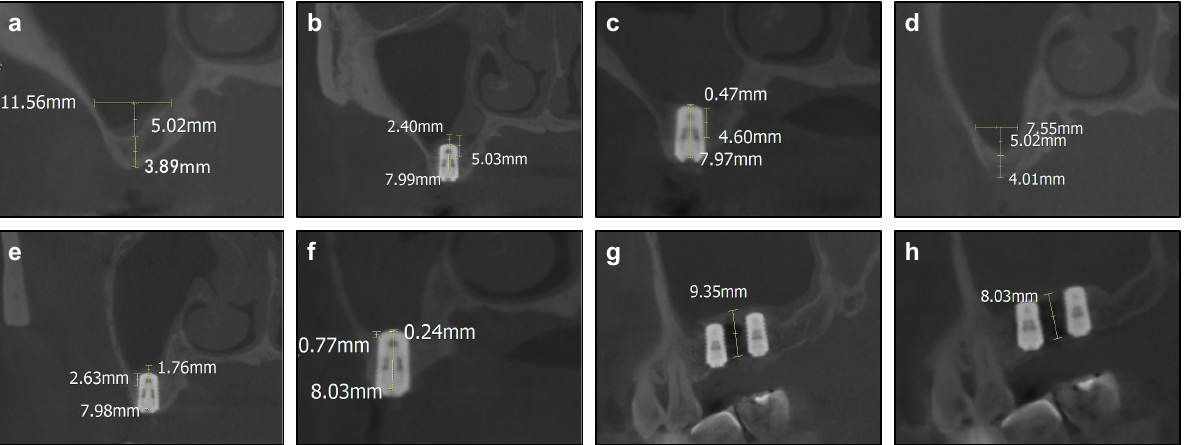
Figure 5. Cone-Beam Computed Tomography (CBCT) and measured data. ( a ) Residual bone height (RBH) of right maxillary first molar before elevation. ( b ) Height of the graft apically (aGH) of right maxillary first molar after elevation. ( c ) aGH of right maxillary first molar 6 months after elevation. ( d ) RBH of right maxillary second molar before elevation. ( e ) aGH of right maxillary second molar after elevation. ( f ) aGH of right maxillary second molar 6 months after elevation. ( g ) aGH between 2 implants after elevation. ( h ) aGH between 2 implants 6 months after elevation.